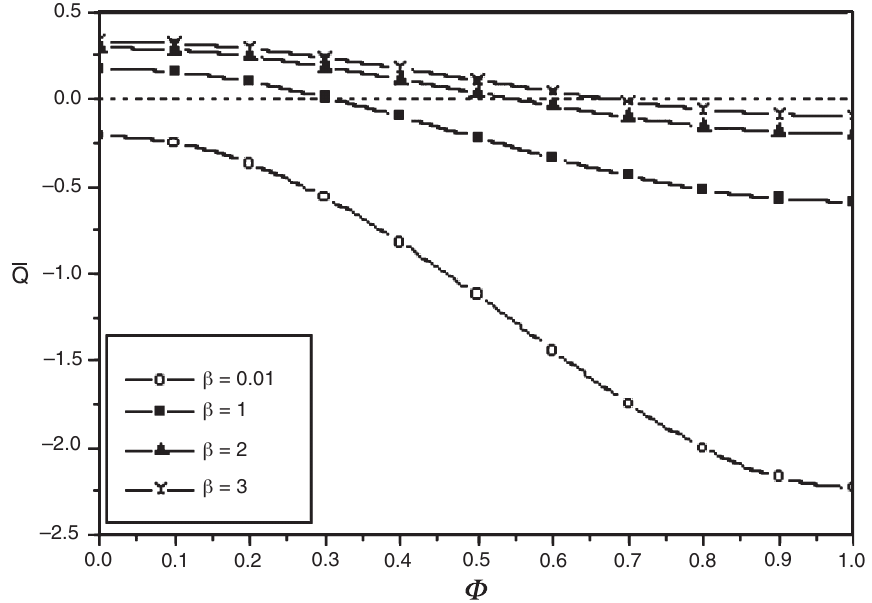
Fig. 8. Variation of Q versus φ with a = b = 0 . 7, d=2 and (cid:9) p=1 for different β